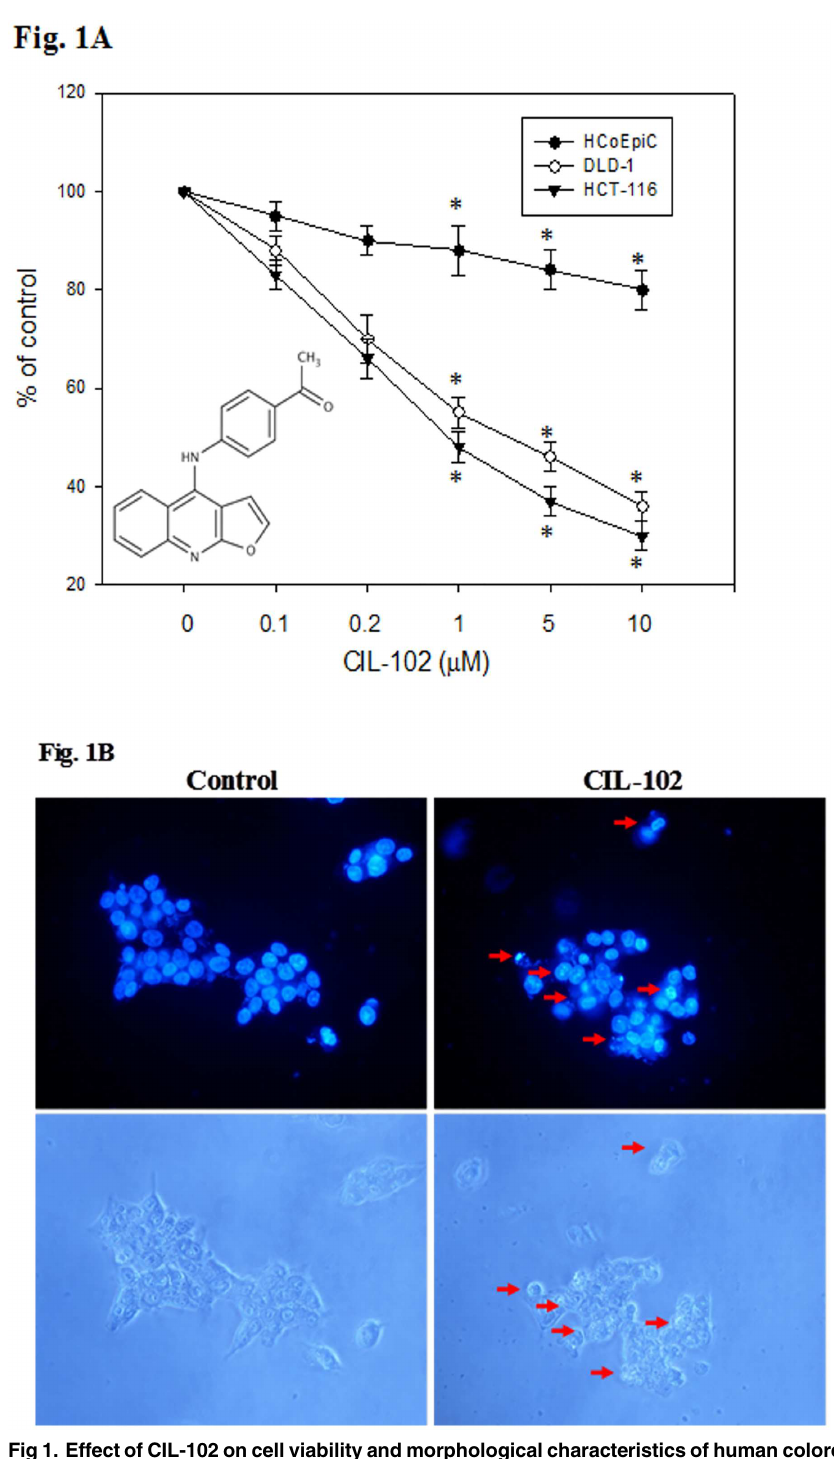
Fig 1. Effect of CIL-102 on cell viability and morphological characteristics of human colorectal cancer DLD-1 cells, and its role in assessingcell death. (A) DLD-1, HAT-116 and HCoEpiCcell were treated with either 0.1% DMSO (as control) or CIL-102 (0.1–10 mM) for 24 h and the proportionof surviving cells was measuredby the MTT assay. (B) Changesin nuclei by DAPI staining. DLD-1cells were treated with vehicle or 1 mM CIL-102for 24 h, and stainedwith DAPI. Apoptoticcells were measuredunder fluorescence microscopy. The data were presented as the mean of three repeats from one independentexperiment.